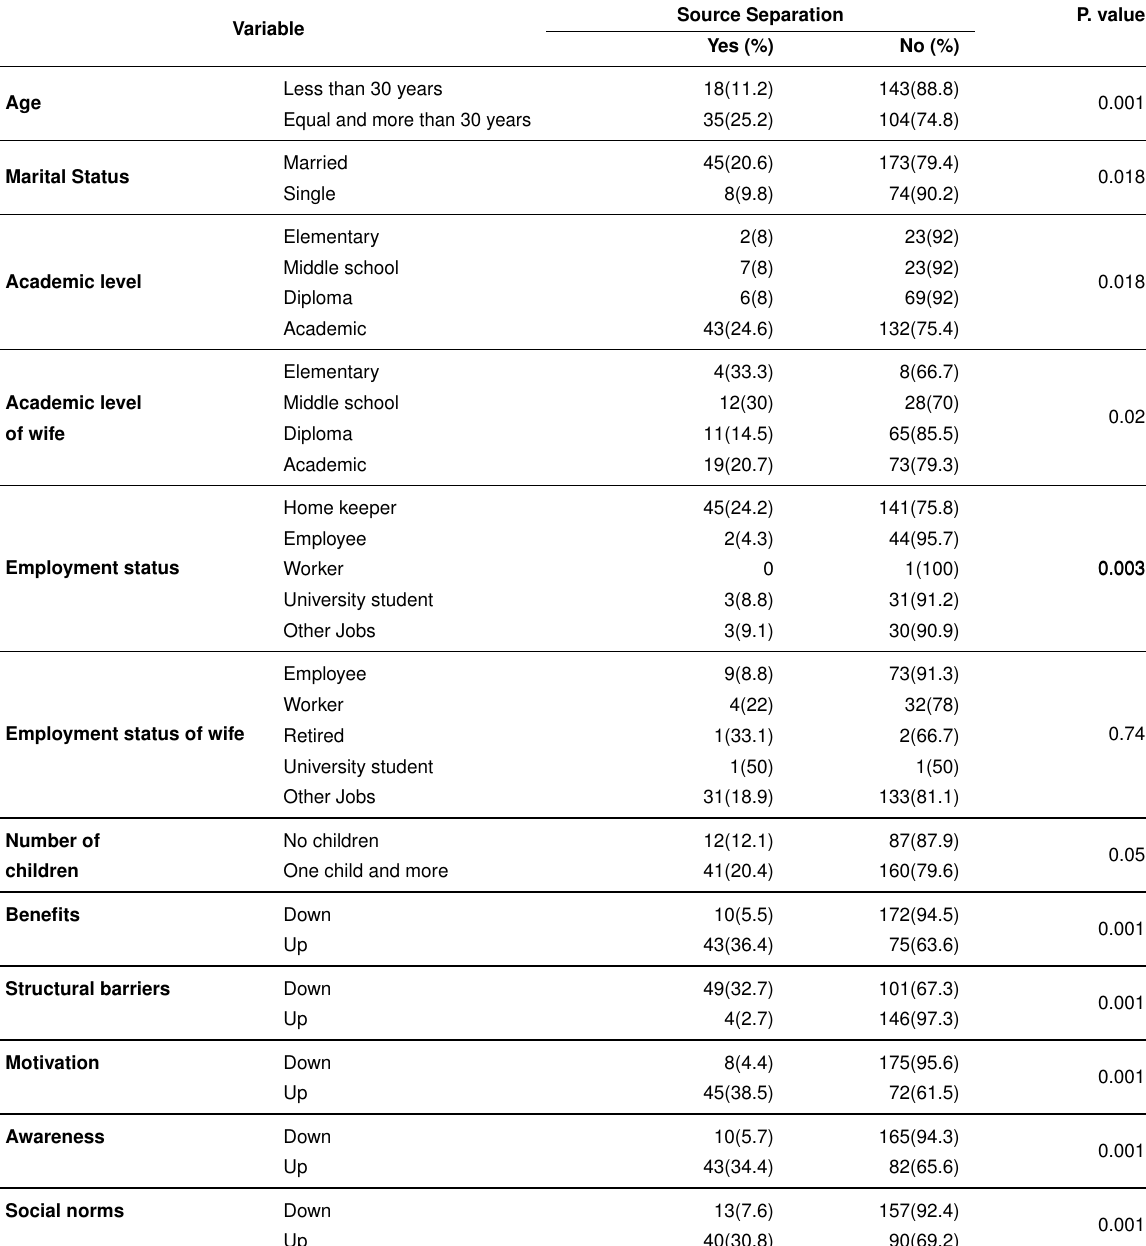
Table 5. Results of the relationship between the source separation behavior and the independent